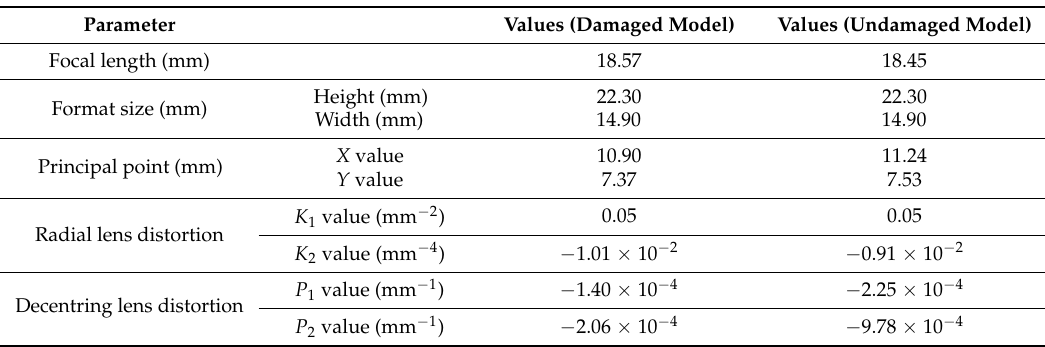
Table 3. Internal parameters obtained during the photogrammetric reconstruction of the damaged and undamaged